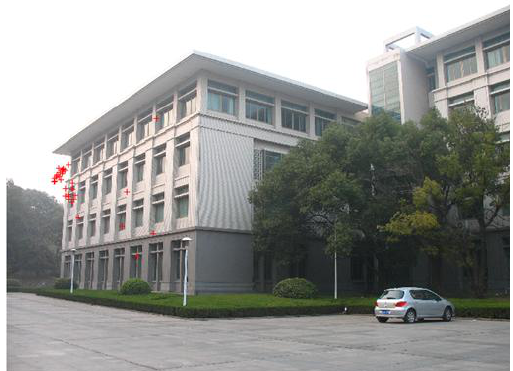
Figure 4: Reconstructed points projected to an image (red crosses)